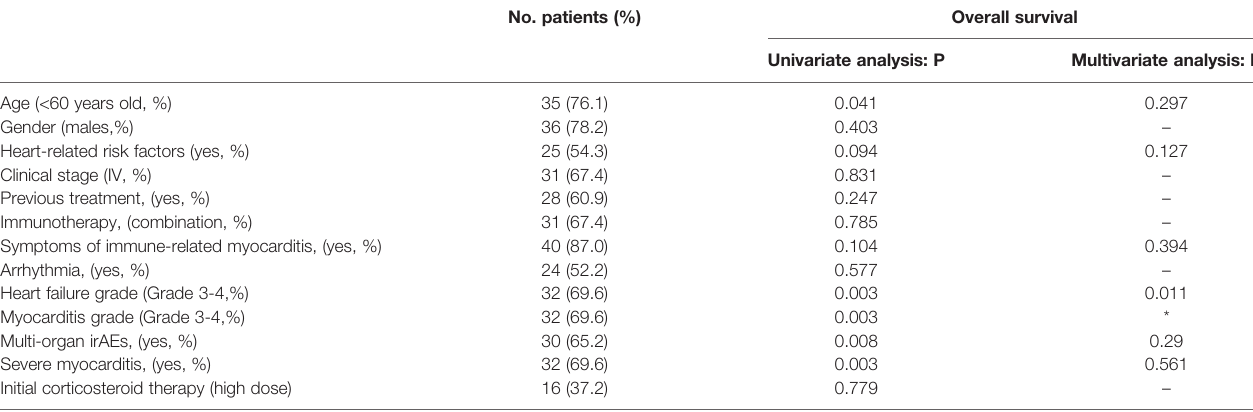
TABLE 4 | Univariate and multivariate analysis of prognostic factors in all